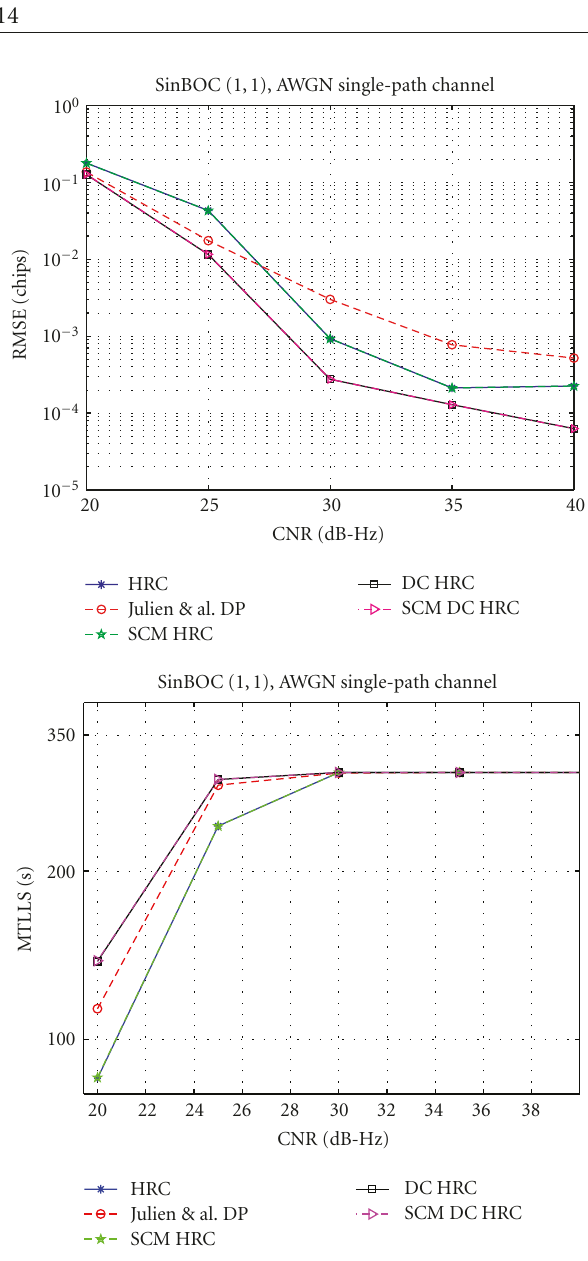
Figure 17: Comparison of feedback delays estimation algorithms employing the HRC discriminator and of the Julien&al. method, as a function of CNR, upper plots: RMSE, lower plots: MTLL. HRC and SCM HRC curves are overlapping; DC HRC and DC SCM HRC curves are also overlapping (di ff erences at the 4th